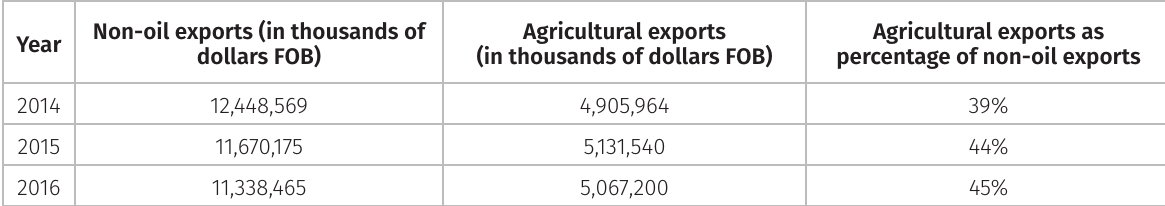
Source: Own elaboration using data obtained from PROECUADOR